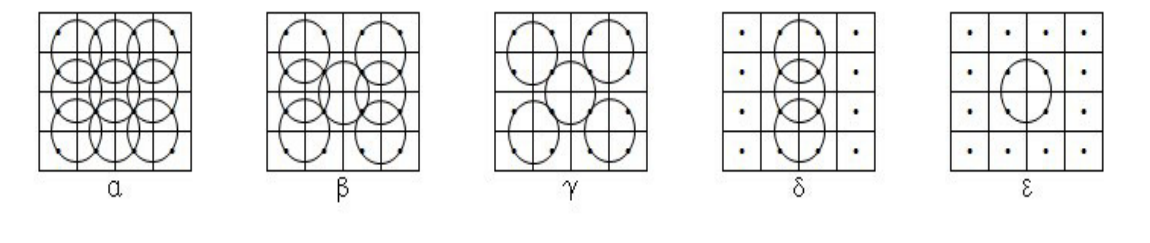
Figure 1: Five Frénicle - Amela patterns